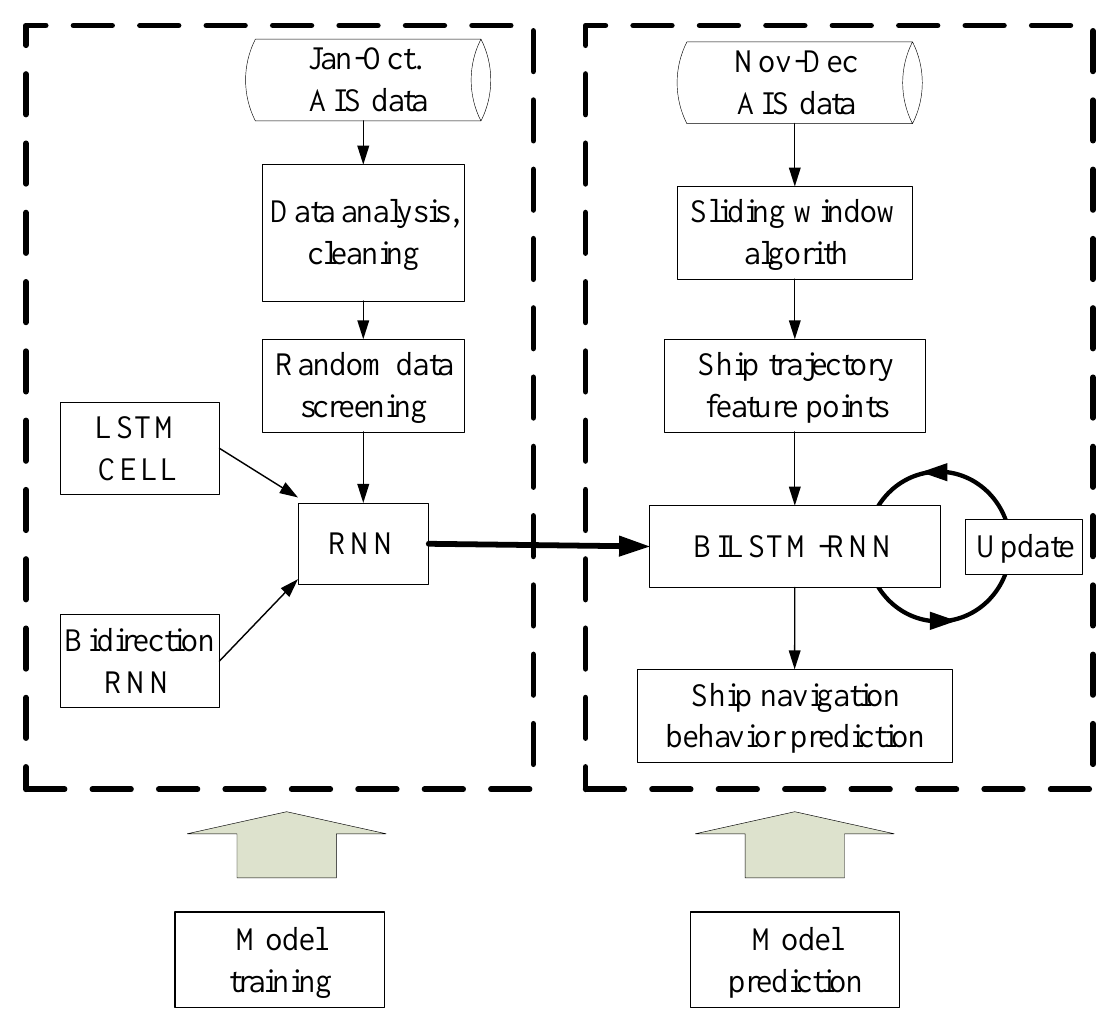
Figure 8. Flowchart of the navigation prediction model using BI-LSTM-RNN.